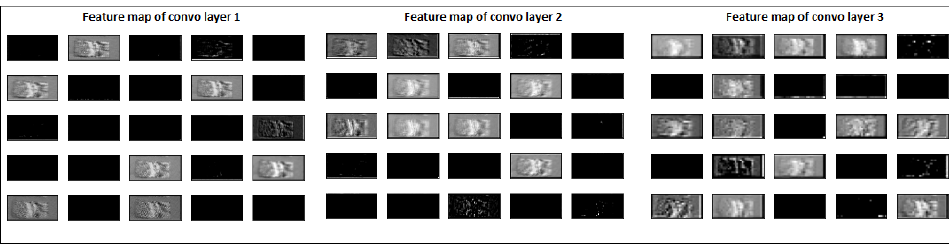
Figure 12. Feature maps of defective layer image 500 after each convolutional layer.